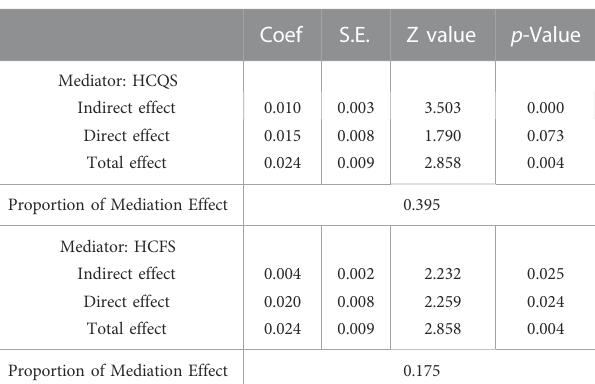
TABLE 6 Results of mediation effect of Sobel